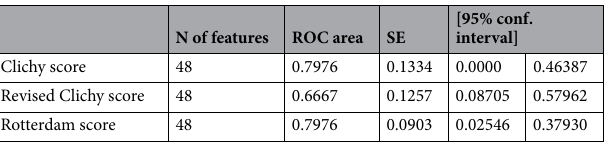
Table 3. Receiver operator characteristics of different prognostic indices as predictors of primary patency.